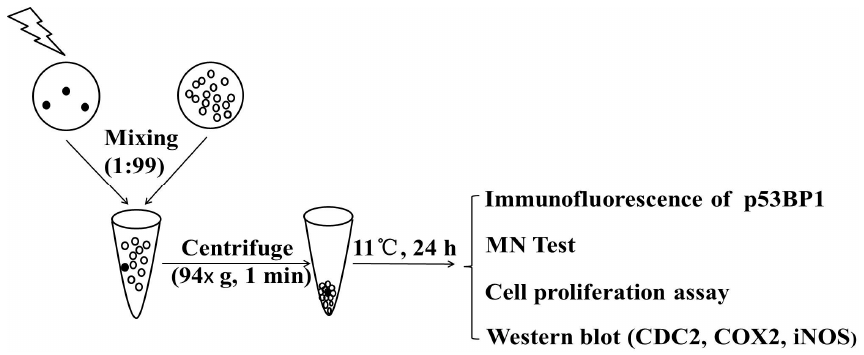
Figure 1. Schematic representation of multicellular cluster. ● : fluorescence labelled cells; ○ : non-fluorescence labelled cells. CDC2: cell division cycle 2; COX-2: cyclooxygenase-2; iNOS: nitric oxide synthase; MN: micronucleus; p53BP1: p53 binding protein 1.